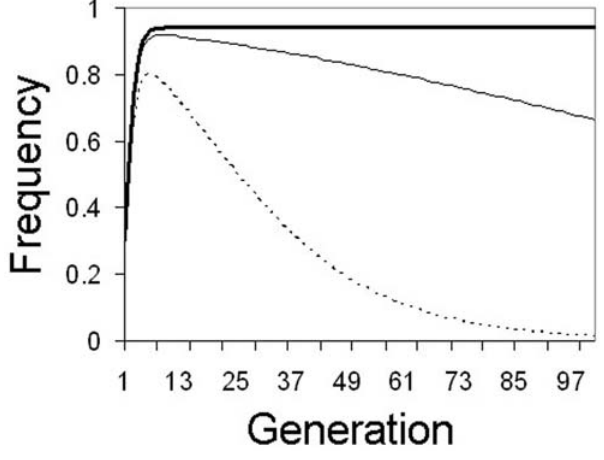
Figure 2. Single mass release. Changes in transgene frequency after a single 30% release of mosquitoes homozygous for a transgene at 4 unlinked loci (8 copies/genome). Thick solid line: No fitness cost ( F =1.0), thin solid line: 1% fitness cost/insert ( F =0.99), thin dotted line: 5% fitness cost/insert ( F =0.95).